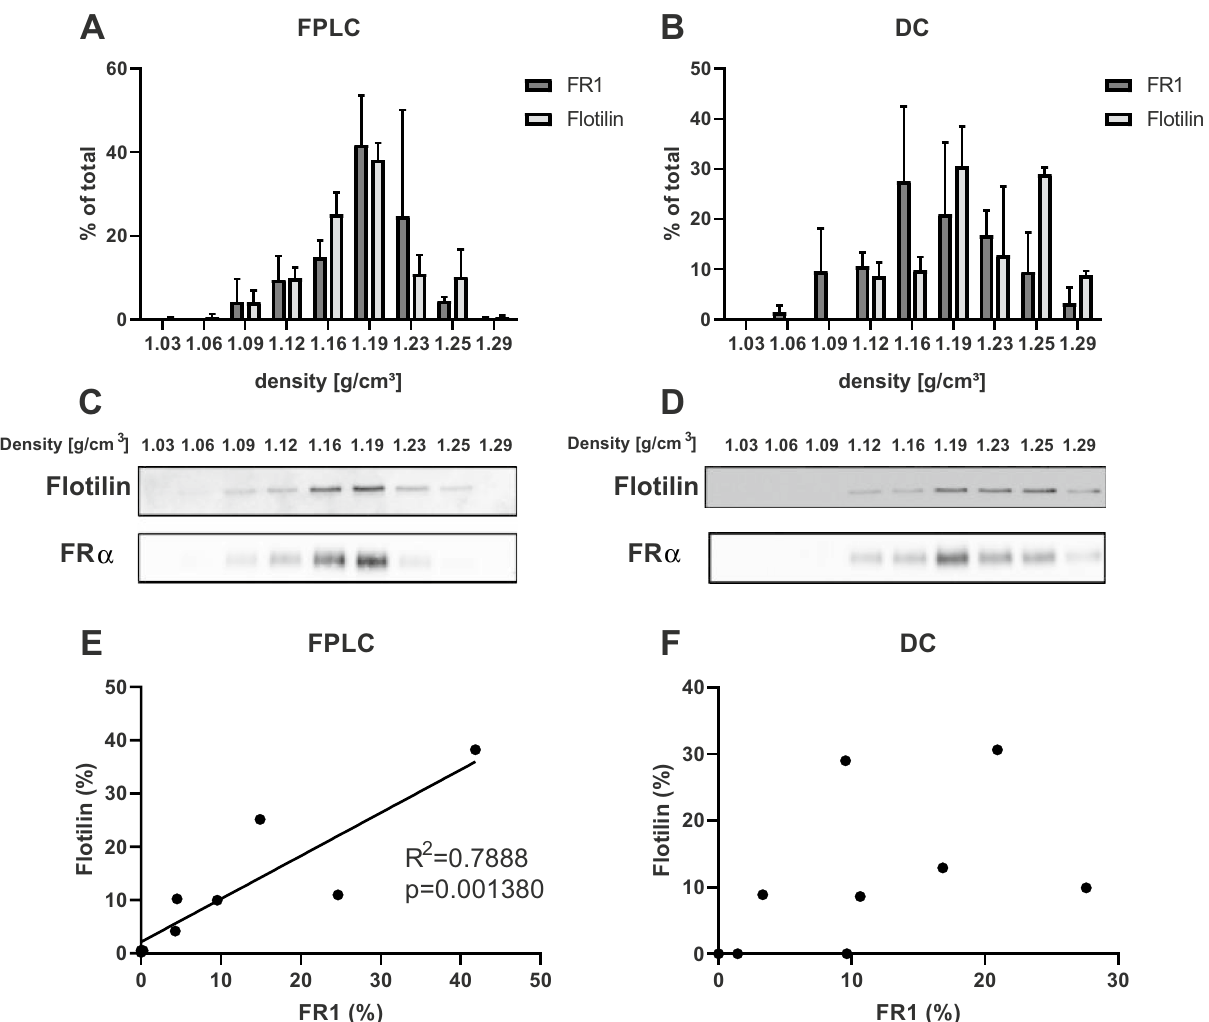
Figure 5. Analysis of EV markers distribution after centrifugation on a sucrose gradient. EVs isolated by FPLC (n = 2) or DC (n = 3 for FRα, n = 2 for flotillin) were centrifuged on a sucrose gradient, then samples from each density layer were analyzed by WB for the EV markers FRα and flotillin. ( A , B ) Pixel intensity was calculated with ImageJ. For each protein, all pixels of a sucrose gradient were summed and single bands were expressed as a percentage of the total pixel amount. Data is represented as mean ± s.d. ( C ) Example of WB of a FPLC-isolated and ( D ) DC-isolated EVs sample. ( E , F ) Correlation between FRα and Flotillin distribution across layers was significant for FPLC samples, but not DC